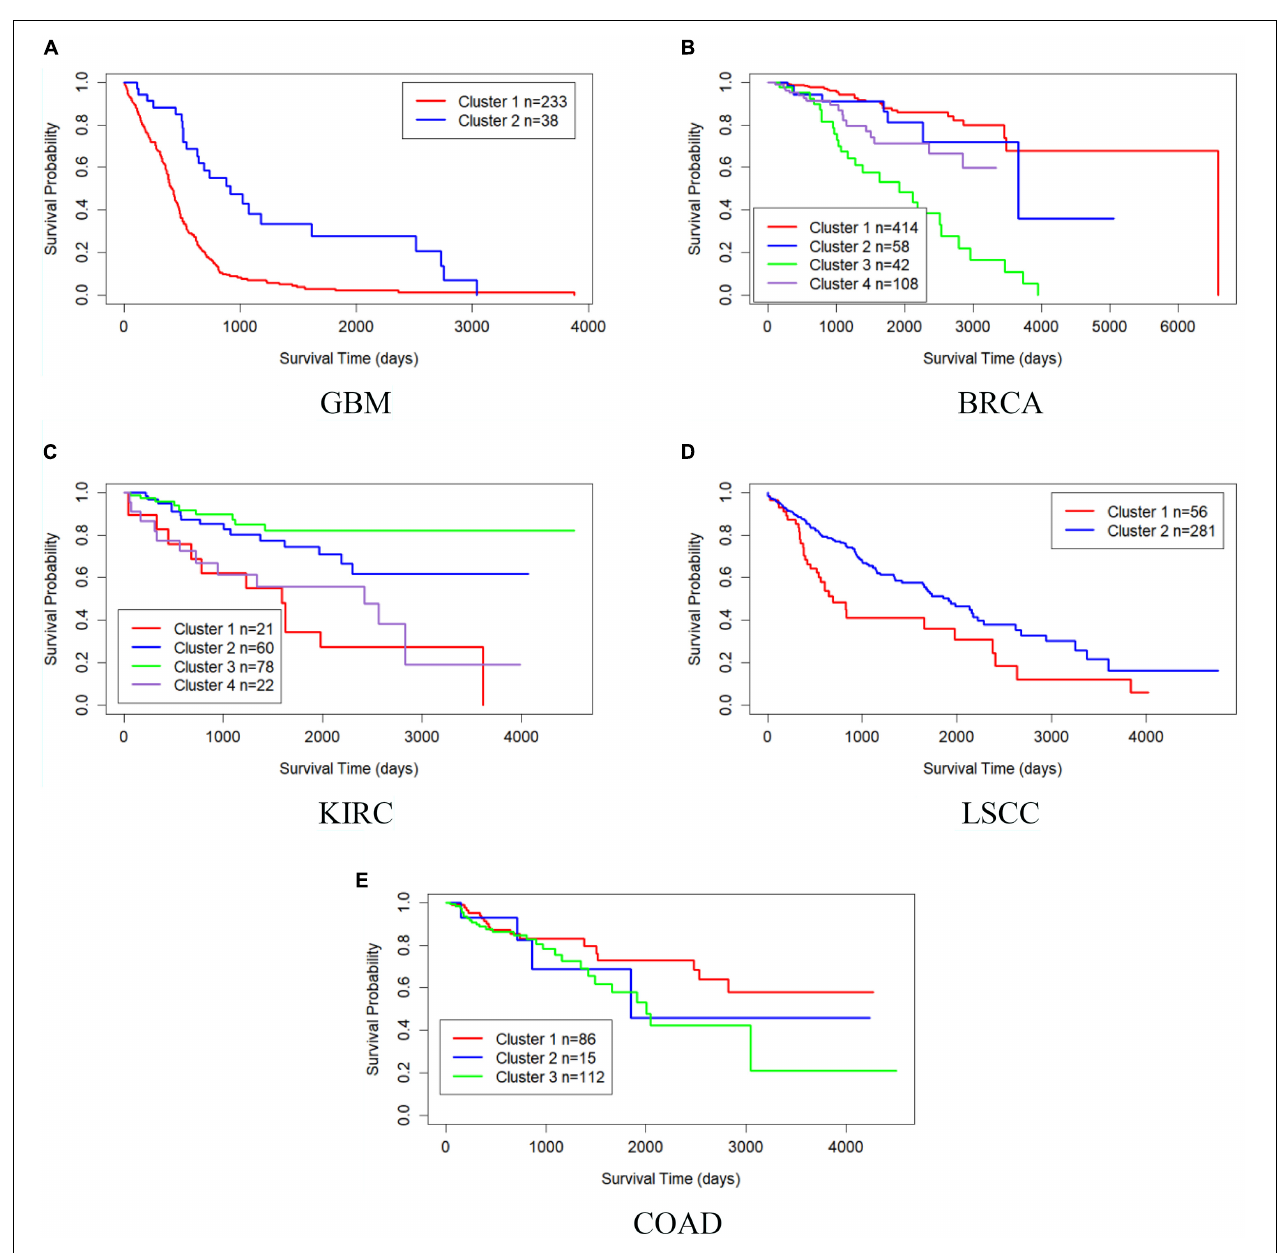
FIGURE 3 | Kaplan–Meier survival curves of MRF-MSC on the cancer types in Rappoport and Shamir (2018). (A) GBM, (B) BRCA, (C) KIRC, (D) LSCC, and (E)